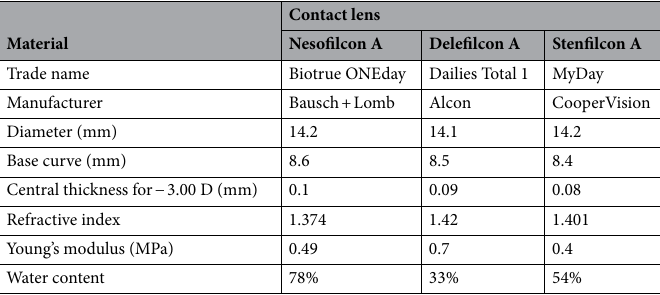
Table 2. Characteristics of the daily disposable SCLs used in the study 11–13 .